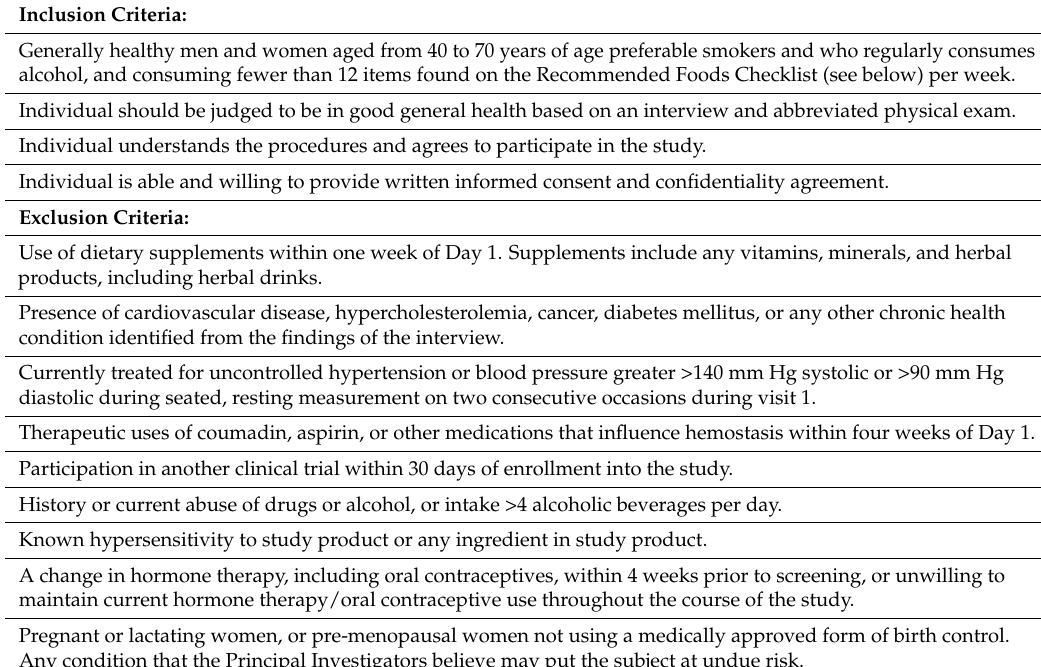
Figure 1. Consort diagram summarizing the subjects disposition for the study. Table 1. Study inclusion and exclusion criteria.